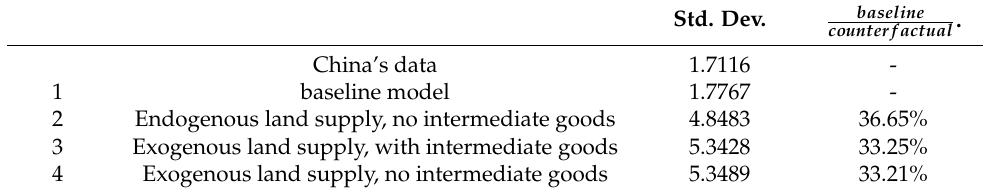
Table 6. Std. Dev. of GDP summary Y t (%).